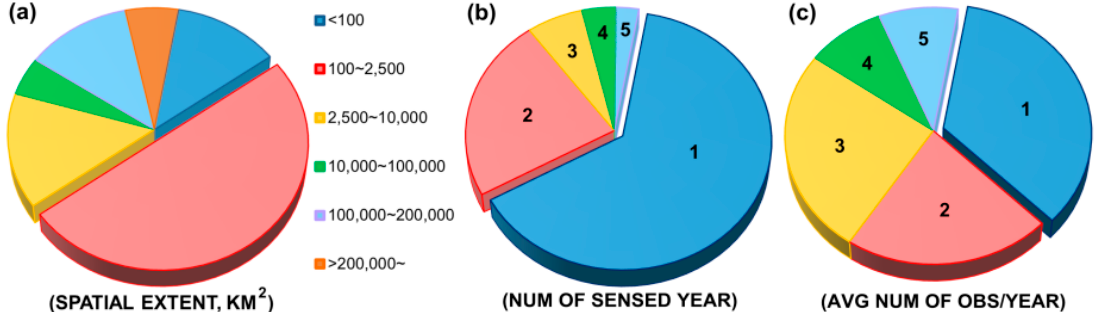
Figure 5. Spatial and temporal overview of published SAR-based snow cover extent (SCE) detection studies. ( a ) The spatial extent of studies; ( b ) number of sensed years; ( c ) average number of observations per sensed year. Note that none of the studies categorized as multi-year monitoring in ( b ) provide a time-series of SCE results, but only few random observations for each year. Thus the average observations conducted per sensed year of each study are illustrated in ( c ).